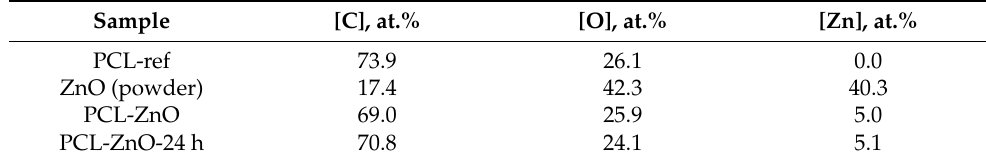
Table 2. Sample atomic compositions measured by XPS.